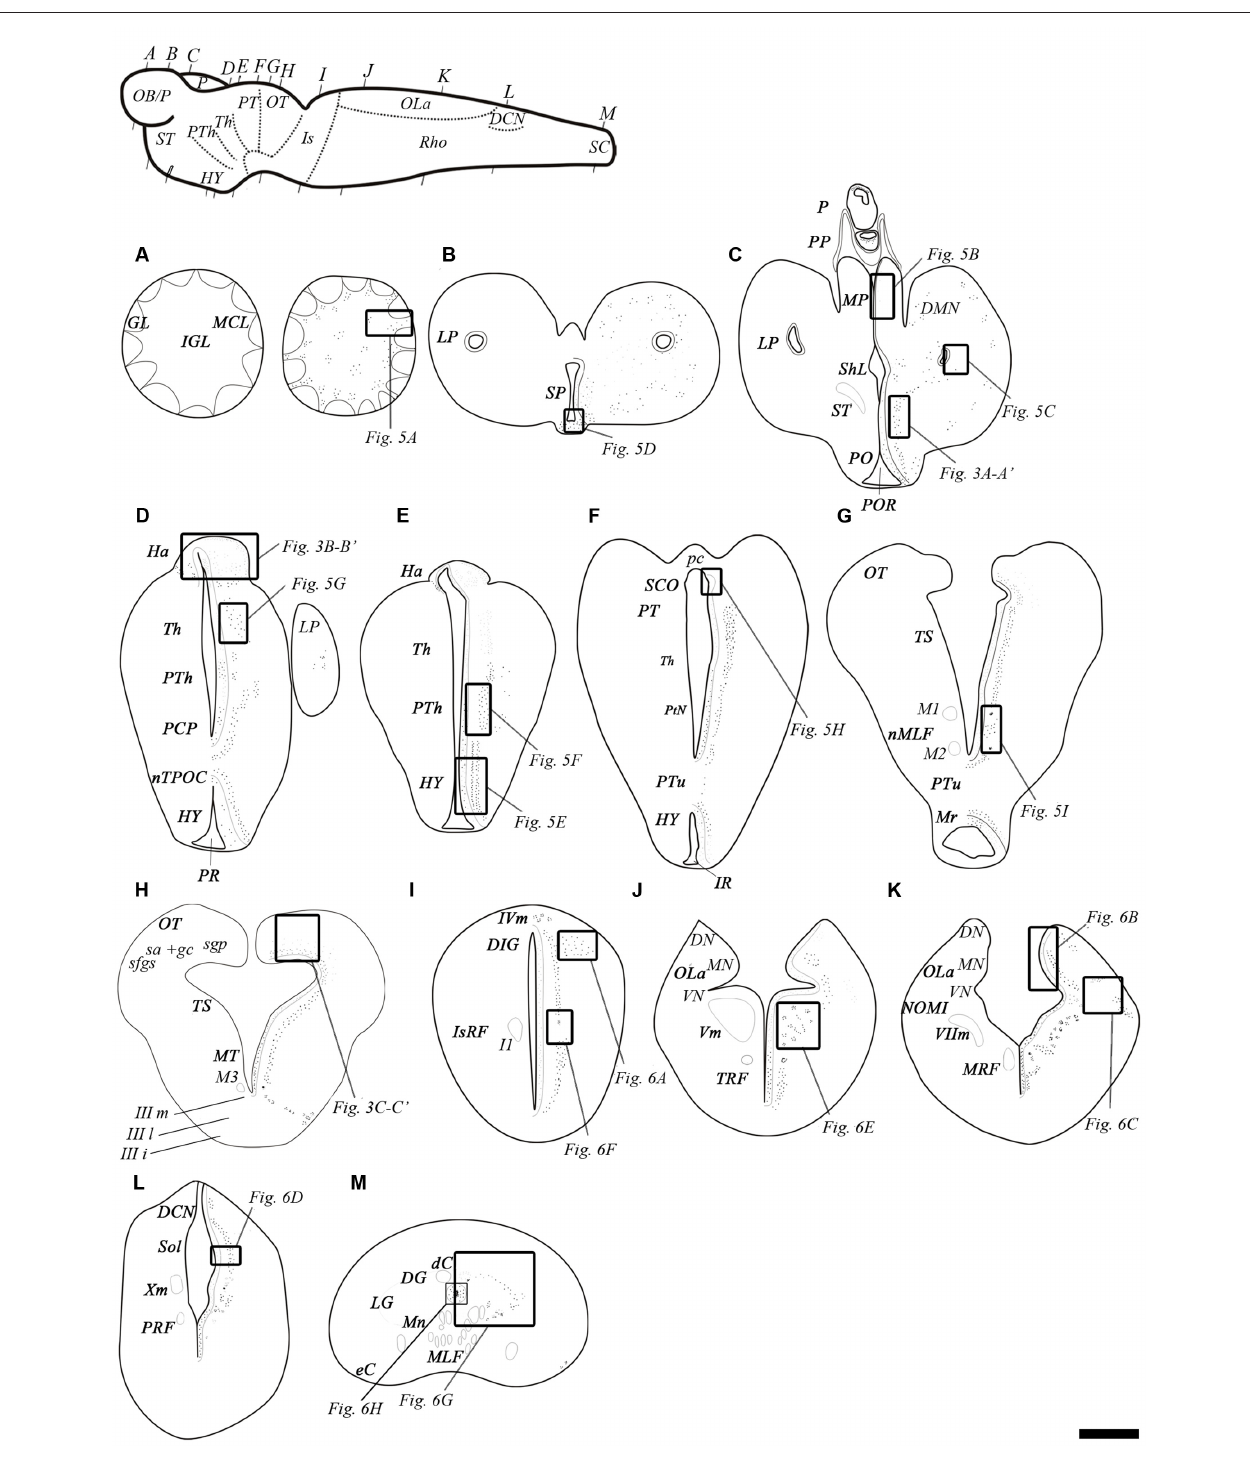
FIGURE 4 | Schematic drawings of transverse sections of the adult sea lamprey brain and spinal cord showing the distribution of GABA B transcripts (on the right side), and the main brain and spinal cord regions (on the left side). (A–G) Representative sections of the prosencephalon in a rostro-caudal order. (G,H) Representative sections of the mesencephalon in a rostro-caudal order. Note that section (G) includes rostral mesencephalic and caudal diencephalic regions. (I–L) Representative sections of the rhombencephalon in a rostro-caudal order. (M) Representative section of the spinal cord. The level of sections is indicated in the upper left figure showing a lateral view of the brain. Dots represent the location and an estimate of the relative density of both GABA B transcripts. Correspondence